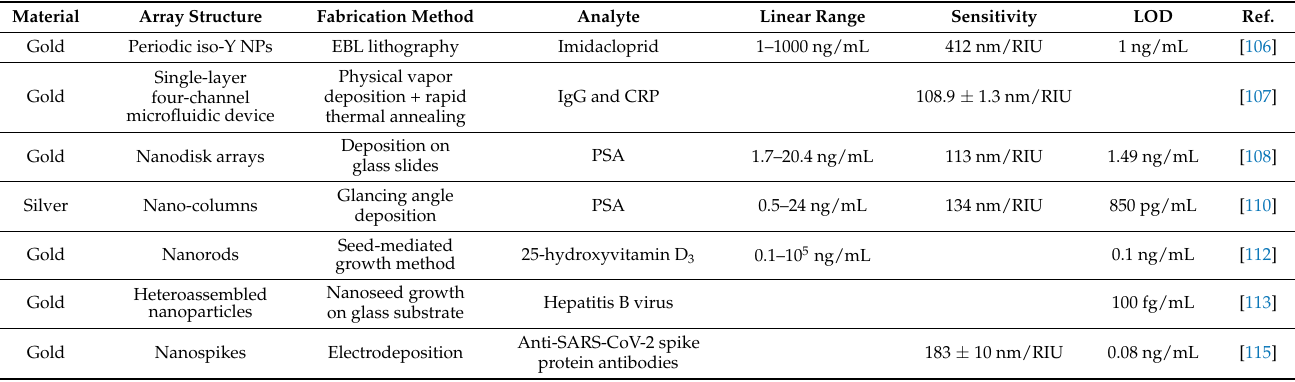
Table 2. Examples of LSPR-based plasmonic